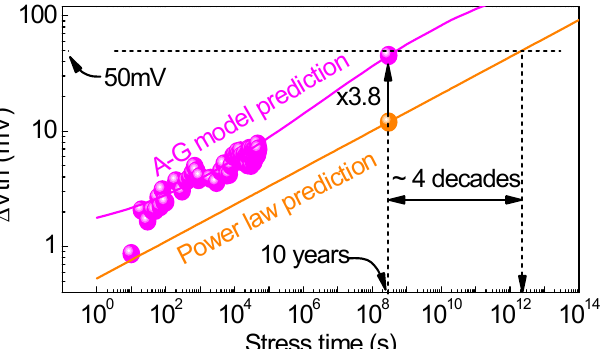
Figure 47. ( a ) Fitting power law with the measured total Δ Vth. The lines are fitted, and the symbols are measured data. ( b ) The extracted power exponent depended on the delay time and stress bias [39].